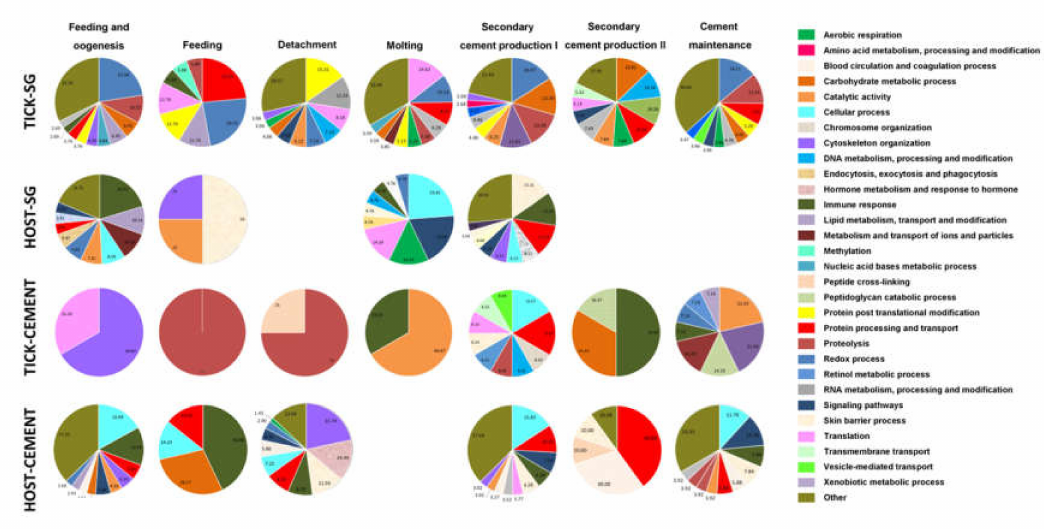
Figure 6. Classification according to biological processes (P) of the host and tick derived proteins identified in the sialome (HOST-SG and TICK-SG) and cementome (HOST-CEMENT and TICK-CEMENT) and putatively assigned to the di ff erent categories of developmental processes including secondary cement production I and II, cement maintenance, feeding, feeding and oogenesis, molting, and detachment. All P were considered, but only the ten most abundant (percentage of representation within the total P per sample) are displayed in the figure. The GO P categories were grouped in di ff erent P and less abundant categories were grouped as Other (Data S4). A high resolution image was include in Data